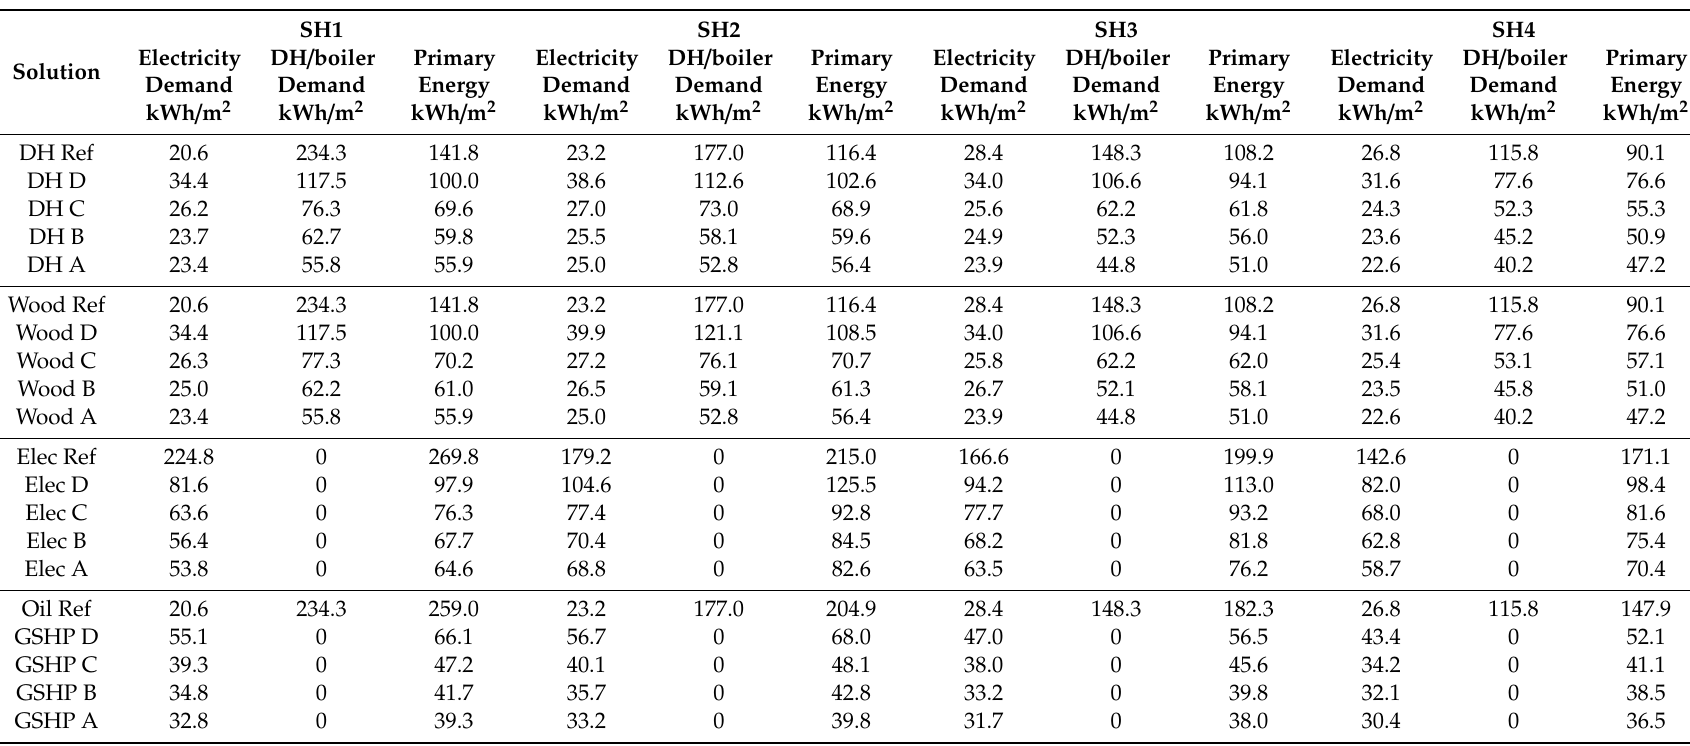
Table A1. Energy demand in the optimized and reference cases. The primary energy factor is 1.0 for oil boiler, 0.5 for wood boiler and DH, and 1.2 for